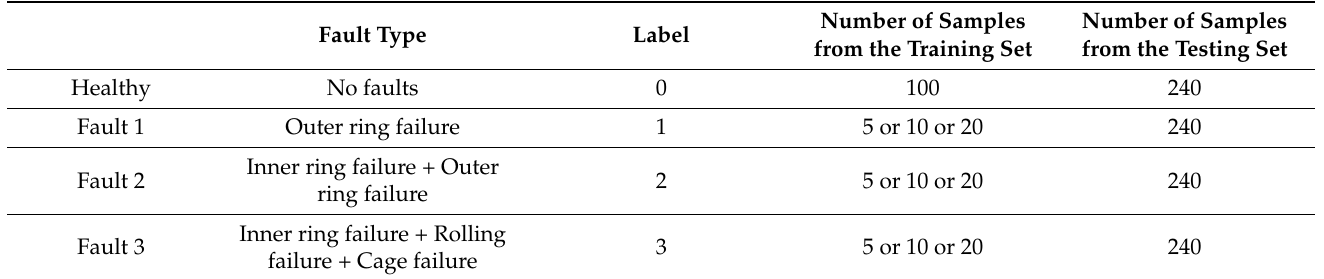
Table 1. Fault description of the generator bearings for wind turbines.